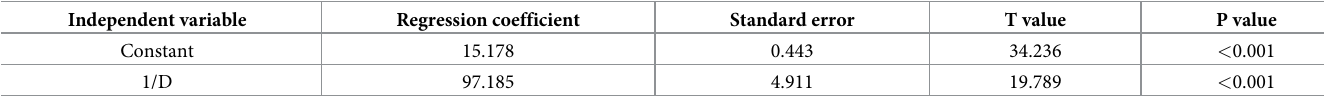
Table 4. Parameters of linear regression model.